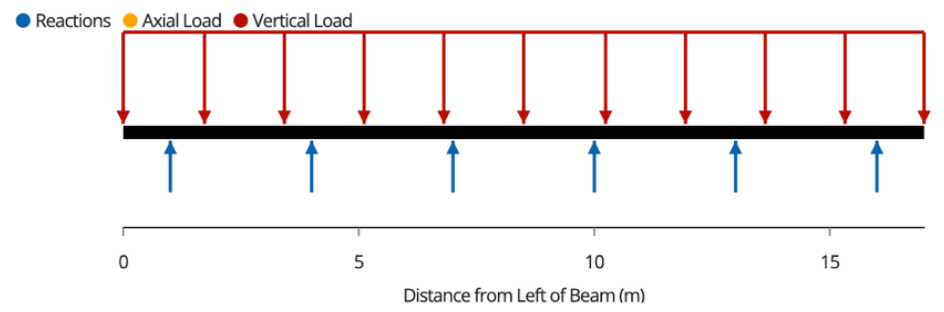
Figure A10. Cantilevered system joists free-body diagram.